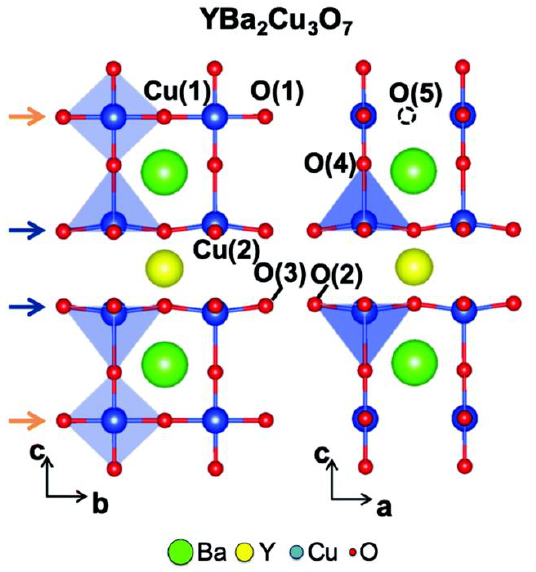
Figure 8. Schematic diagram of the YBCO unit cell. Reprinted with permission from Ref. [64]. Copyright 2020, Royal Society of Chemistry.